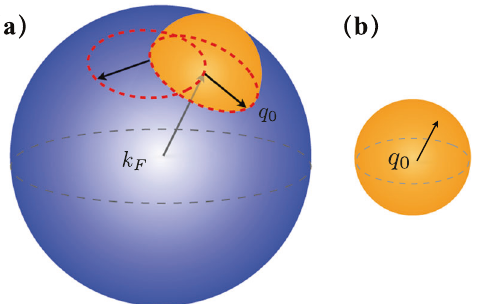
Fig. 1 The coupling between Fermi surface and critical boson surface. a The blue sphere is the Fermi surface of the conduction electrons. The orange surface represents the critical boson surface. k F is the Fermi momentum, and q 0 is the radius of the boson surface. The Yukawa coupling connects fermions with a ring of fermion modes on the Fermi surface. b The critical boson sphere.